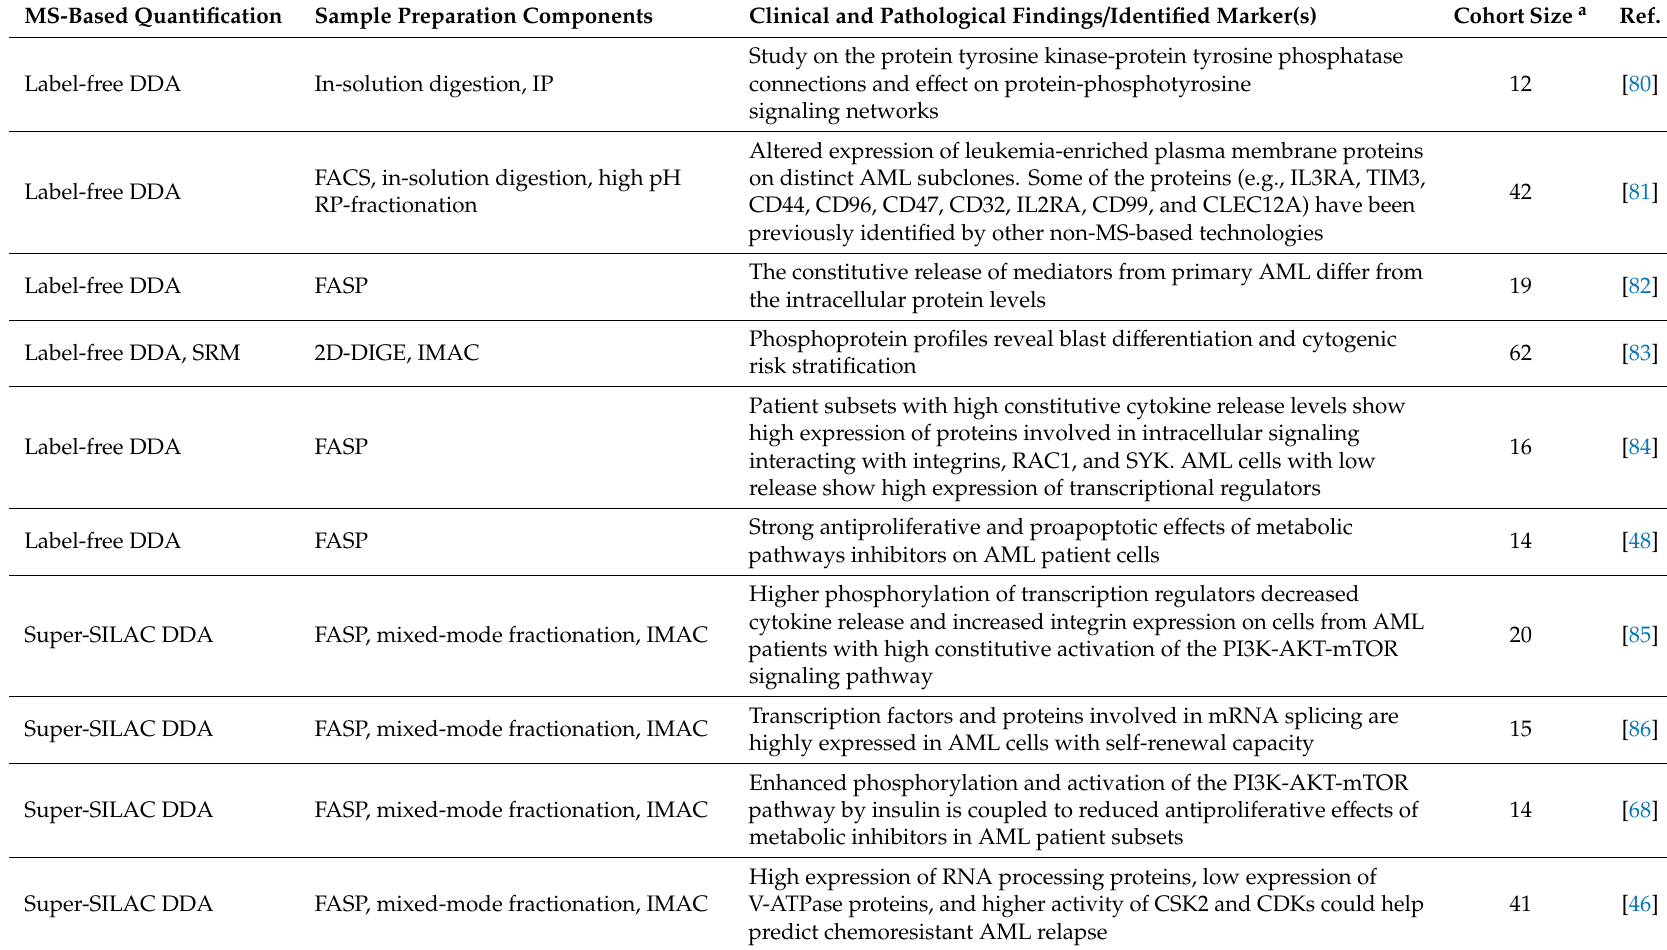
Table 2. Liquid chromatography-tandem mass spectrometry (LC-MS / MS)-based proteomics from recently (2017–2020) published studies of AML patient